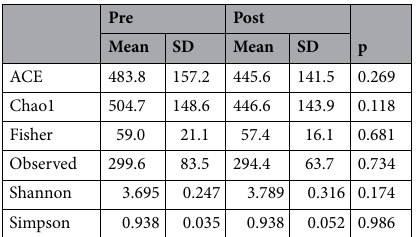
Table 1. Comparison of α-diversity indices of intestinal microbiota (OTU level) before (Pre) and after (Post) the